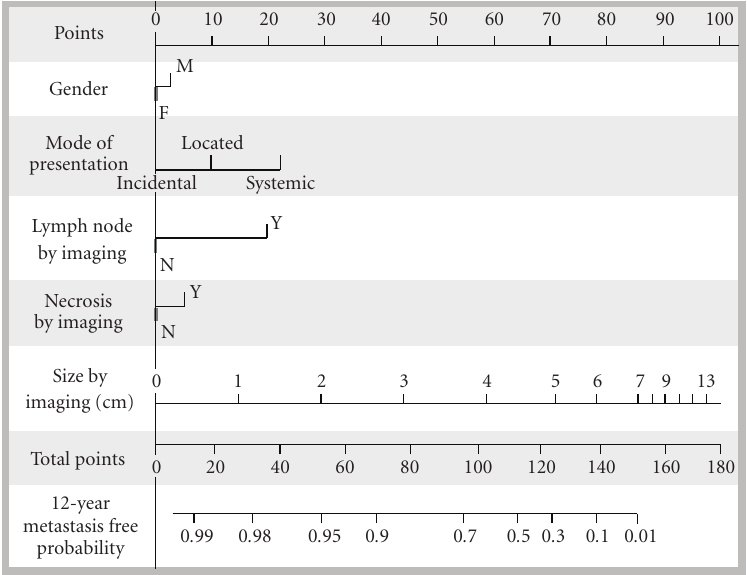
Figure 1: Preoperatory prognosis RCC nomogram [27].